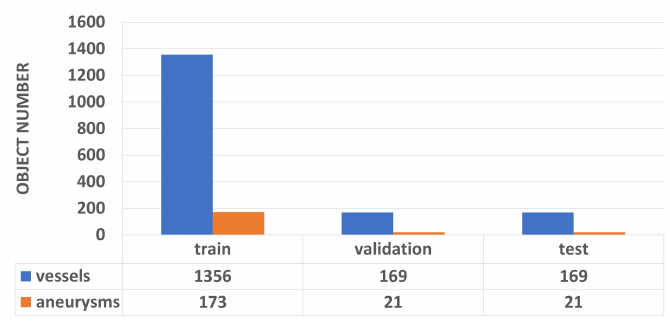
Figure 6. Vessels and aneurysms distribution in the train, validation, and test.